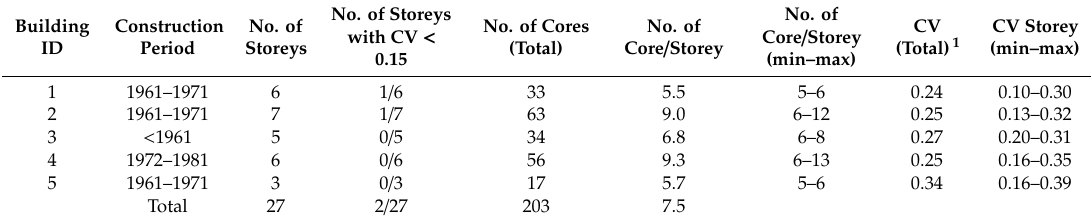
Table 5. Selected buildings for the analysis of within-storey variability.